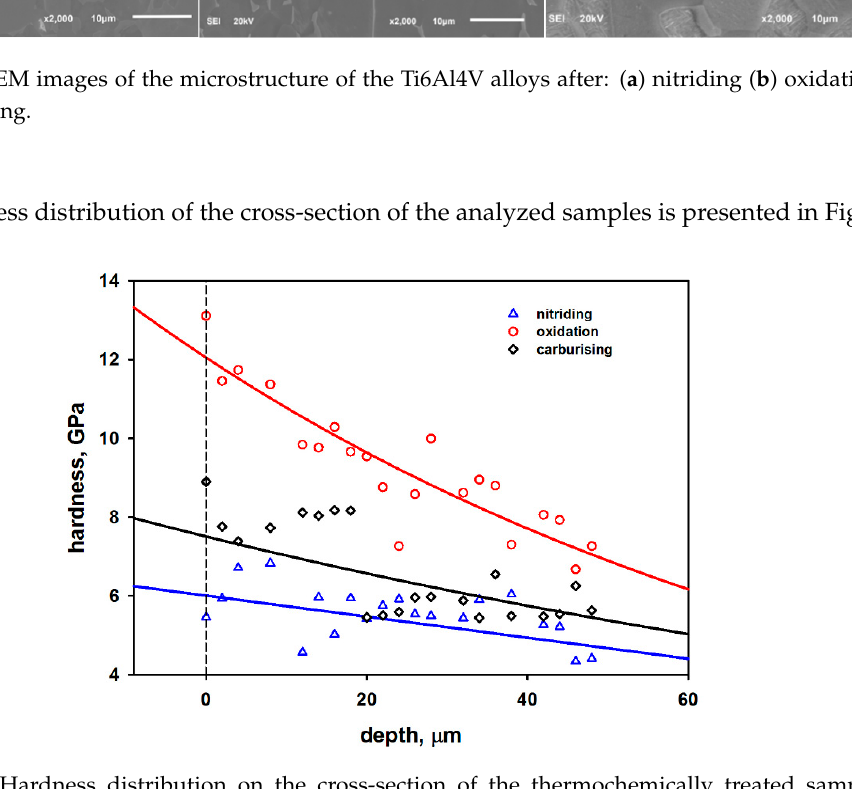
Figure 4. Hardness distribution on the cross-section of the thermochemically treated sample. The hardness is presented with respect to the distance from the surface of the sample.